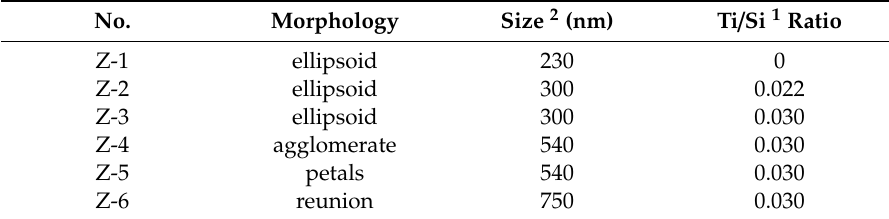
Table 1. Textural properties of Silicalite-1 / TS-1 zeolites.